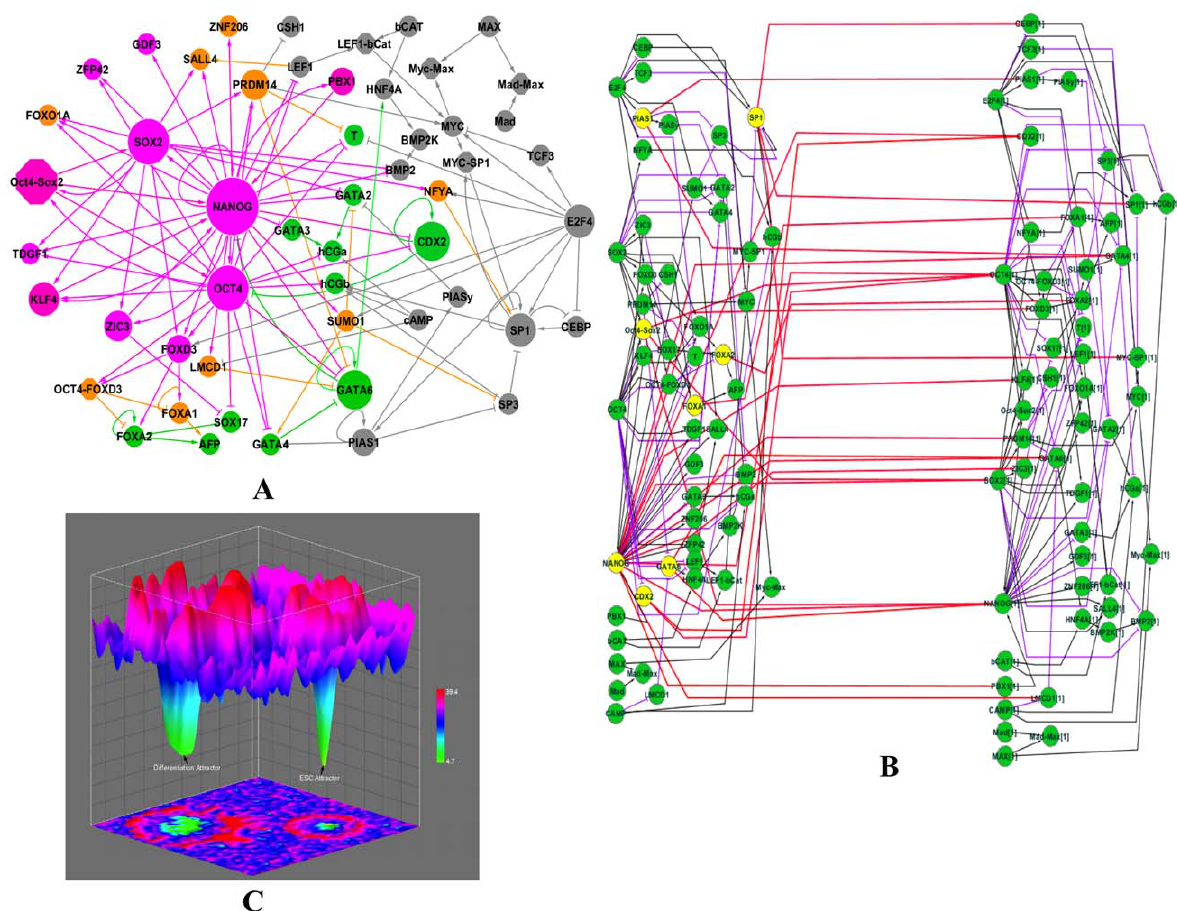
Figure 1. Epigenetic landscape. ( A ) . Genetic network regulating self-renewal and differentiation of hESC. Active and repressive regulations are represented by arrow and bar links, respectively. Node size is proportional to a node’s total degree (sum of incoming- and outgoing- degrees). The hESC and differentiation markers are colored in pink and green, respectively. The genes positively regulated by hESC markers are colored in orange. ( B ) . 2-time slice Bayesian Networks (2TBN) model of genetic network in hESC. The 2TBN consists of 2 slices of Bayesian networks and each slice contains a complete set of 52 nodes in the original network. All the loops are deconvolved into inter-slice edges (in red), which represent the regulations between the regulators in the first time slice (interface proteins, colored in yellow) and the regulated genes in the second time second time slice. The outgoing interface consists of NANOG, SP1, Oct4-Sox2, CDX2, PIAS1, GATA6, FOXA2, and FOXA1. The purple and black edges represent intra-time slice down regulating and up regulating effects, respectively. ( C ) . Illustration of the cell-state potential landscape. The color represents the potential of the cell state. The higher the potential, as represented on the z-axis, indicates a smaller probability of that particular cell state. X and Y coordinates specify unique cell